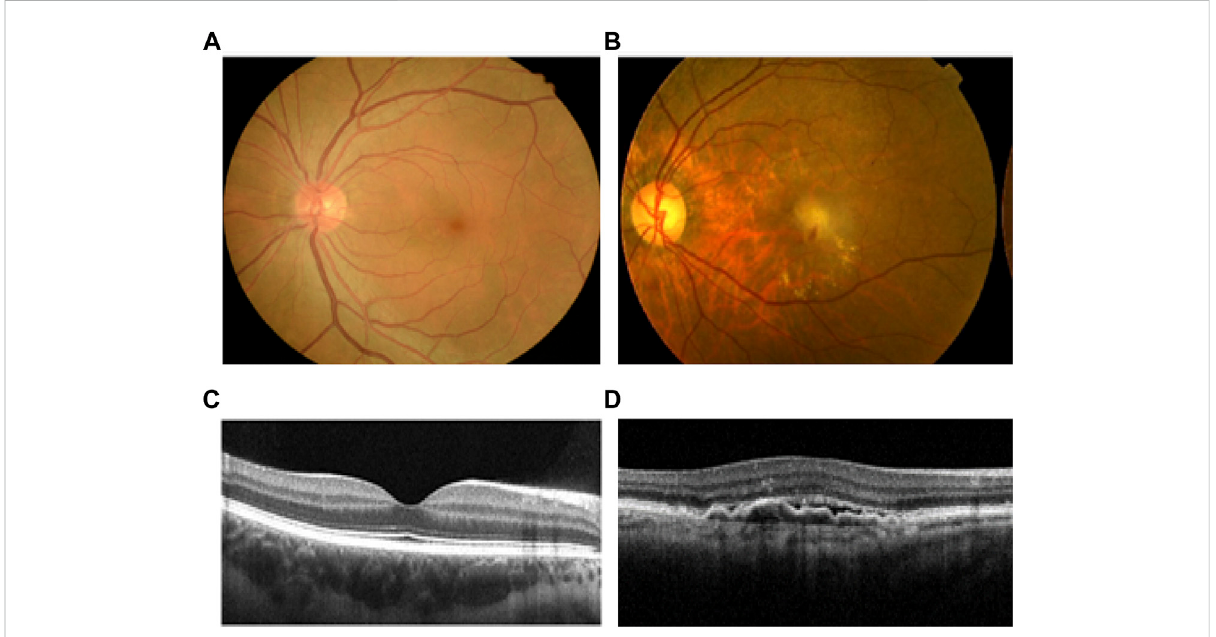
FIGURE 1 Comparison of health and AMD human retina. (A) Normal human fundus image of the left eye. (B) Fundus image of a patient with left eye wet AMD,withdrusen,exudate, subretinalhemorrhageandscarring atthemacularregion. (C) OCTimageofnormalmacula. (D) OCT imageofwetAMD macula. AMD, age-related macular degeneration; OCT, optical coherence tomography.